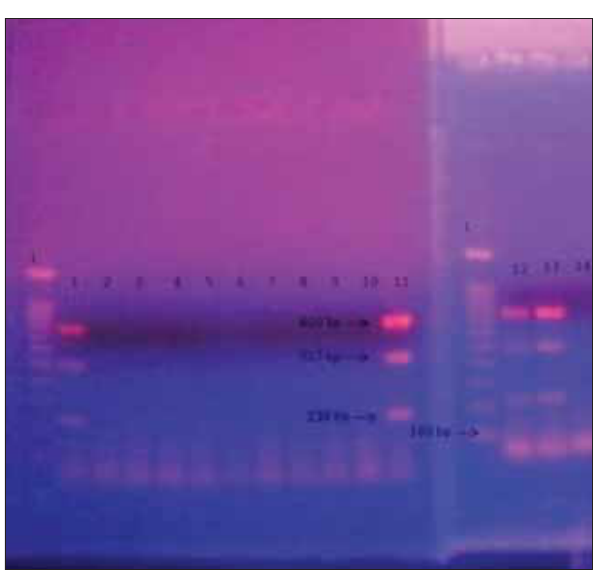
Figure-1: Agarose gel electrophoresis of multiplex polymerase chain reaction products obtained